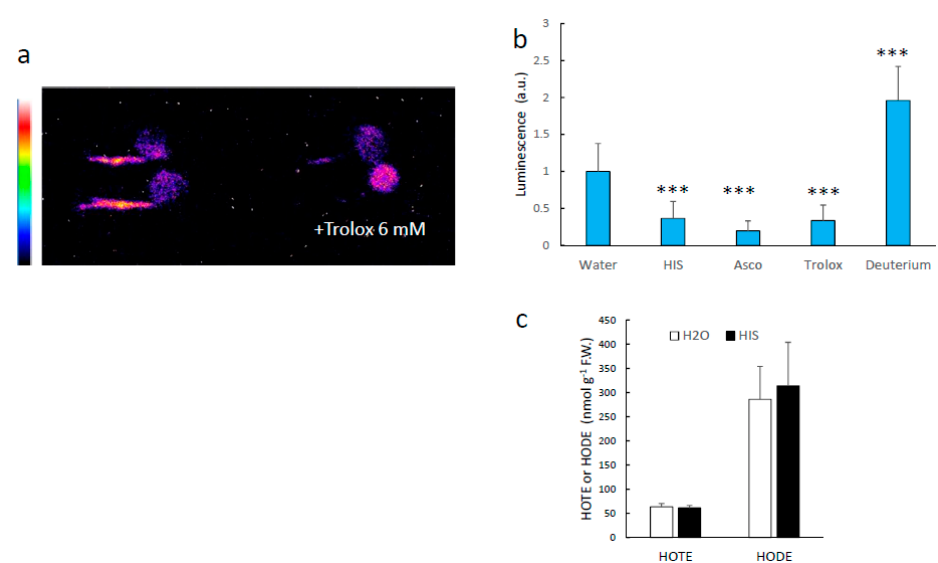
Figure 9. Effect of singlet oxygen quenchers on the intensity of pea root SCL. ( a ) SCL image of wounded pea roots and the effect of several singlet oxygen quenchers (His, Trolox, ascorbate). ***, significantly different from water at p < 0.001 (Student’s t -test). ( b ) quantification of root SCL under the conditions shown in panel a. ( c ) HOTE and HODE levels in wounded roots treated or not with His.